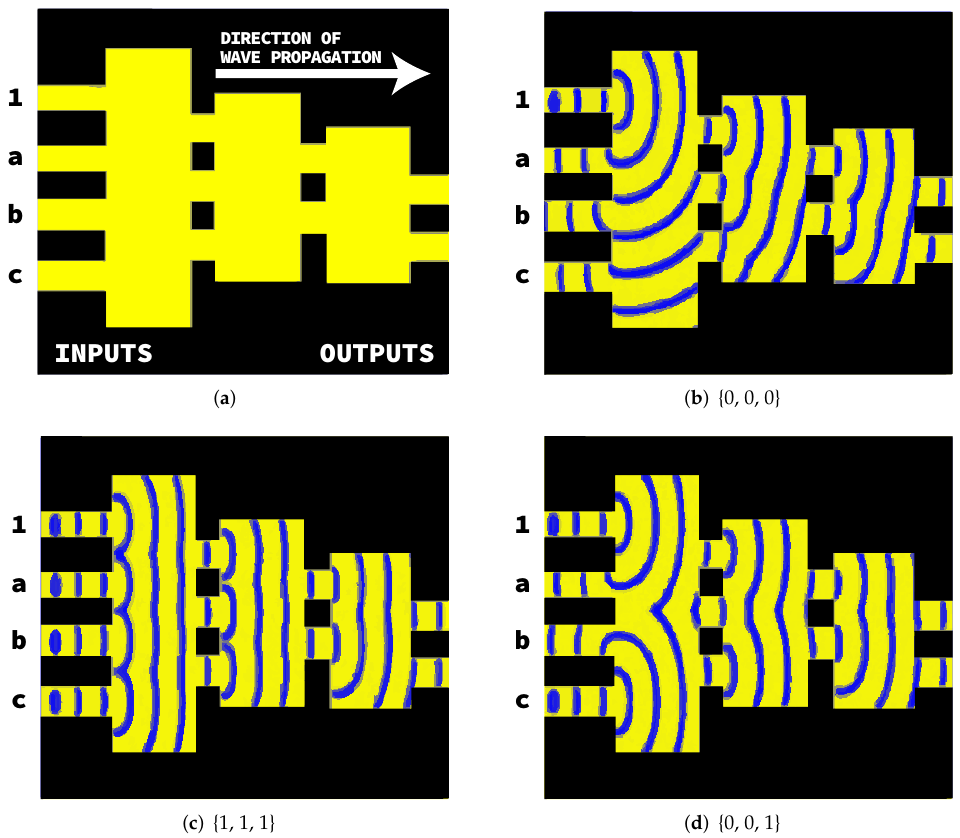
Figure 2. ( a ) Chemical OR gate topology as proposed in [23]. ( b – d ) Chemical waves propagation for different input combinations { a , b , c }